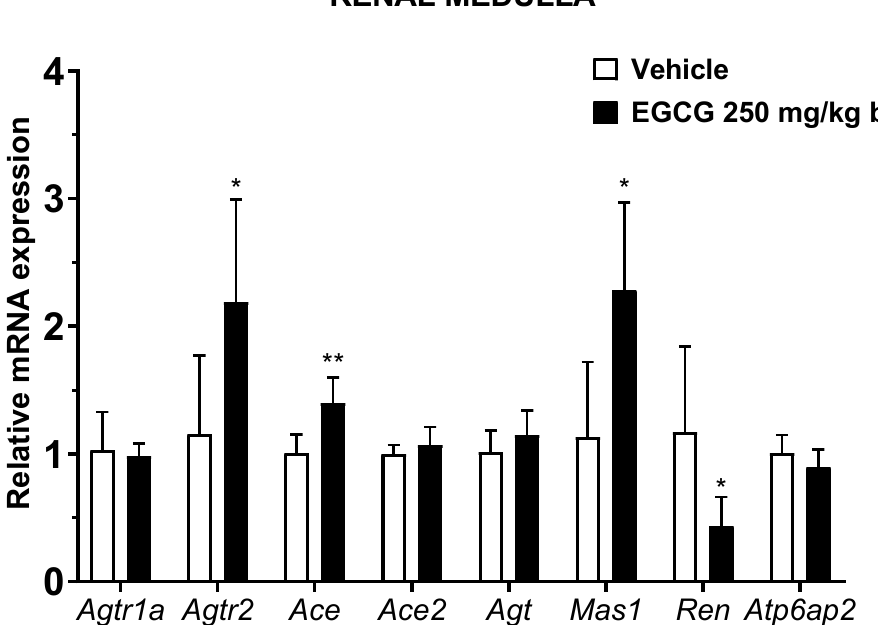
Figure 4. Relative mRNA expression of RAS related genes in renal medulla. Data were normalized to the Gadph gene expression and expressed as mean ± SD, n = 6. * p < 0.05, ** p < 0.01 vs. vehicle, Student’s t -test.